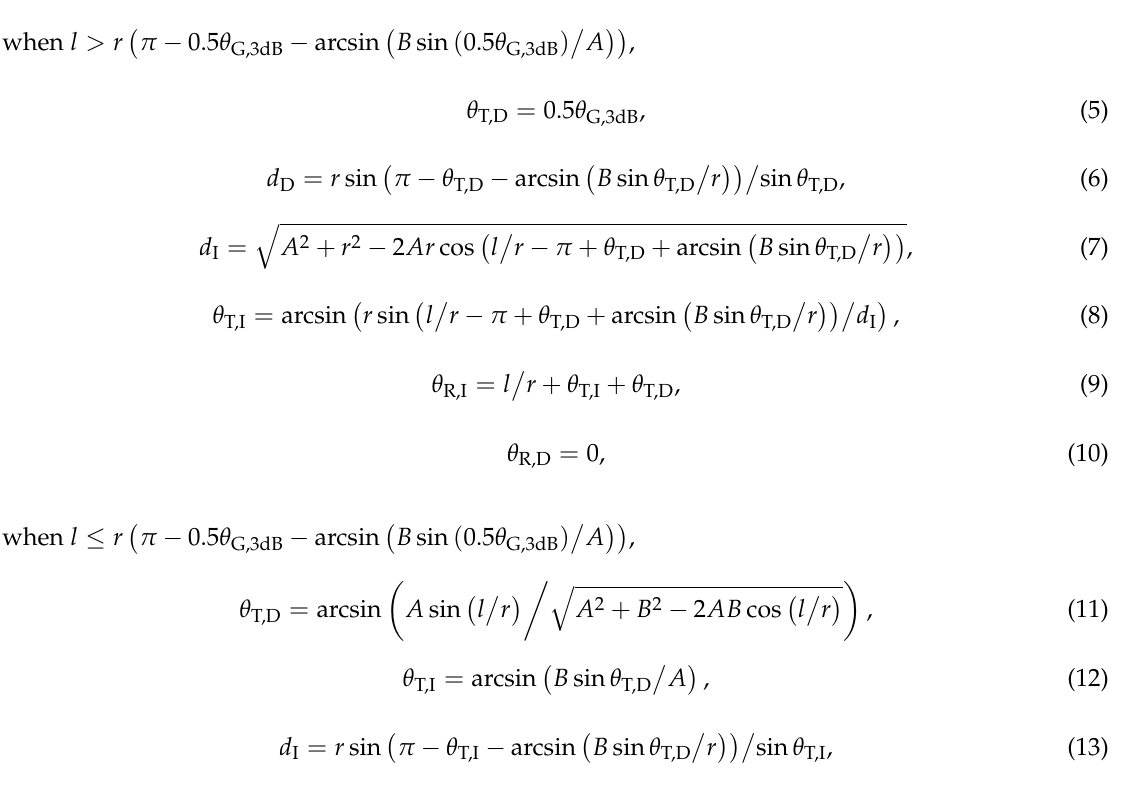
Figure 3. Geometrical configuration in the worst case. ( a ) GEO user; ( b ) LEO